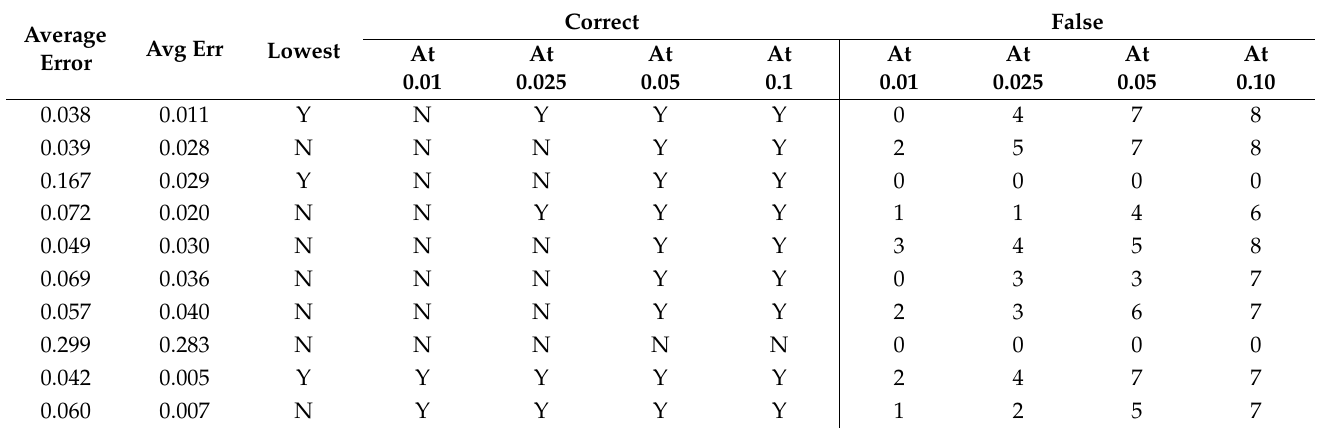
Table A91. Set 2, trials 1–10 summary data (single 0.5 PR value).